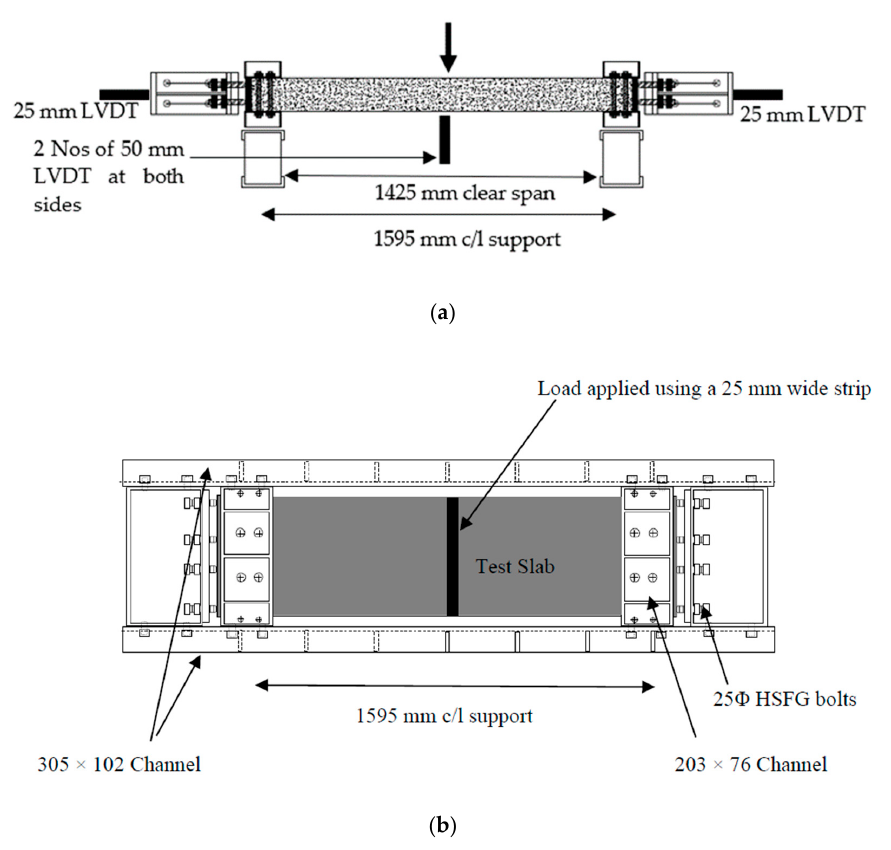
Figure 3. Test set up and test rig. ( a ) Side elevation of the test setup. ( b ) Plan view of the arrangement of the slab inside the test rig.